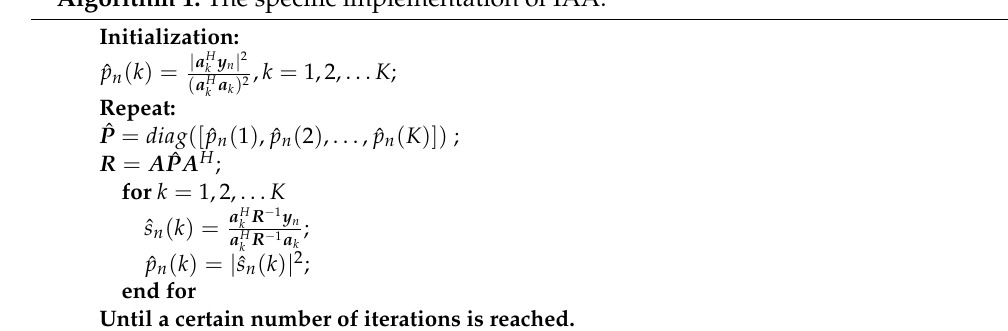
Algorithm 1: The specific implementation of IAA.